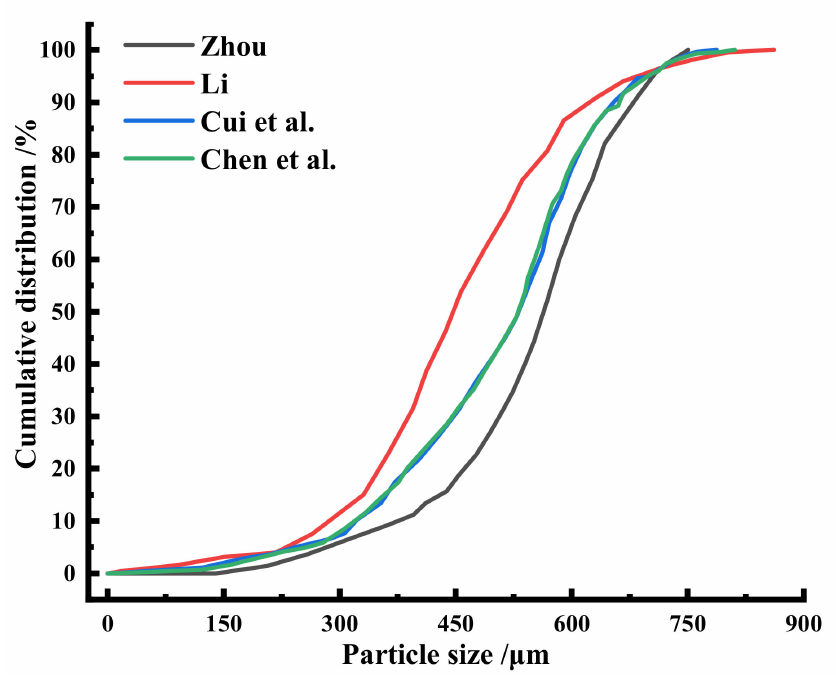
Figure 2. Particle size distribution of MS [9–12].